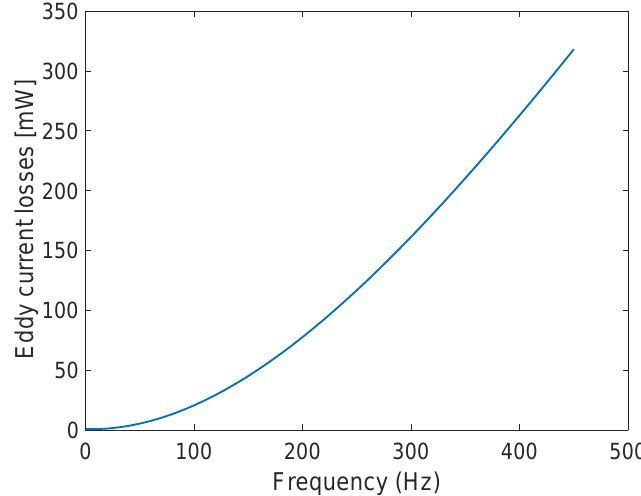
Figure 9. Eddy current losses dependence on frequency.